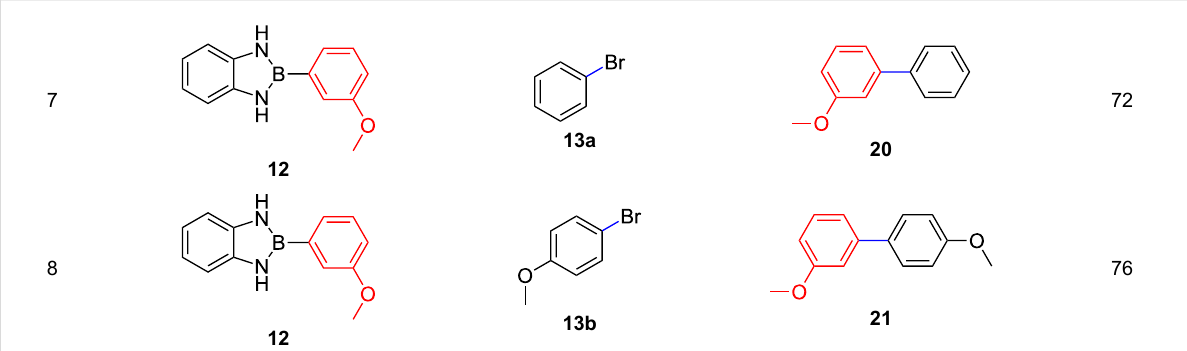
Table 2: Palladium-catalysed cross-coupling of boronate 9 – 12 with bromobenzene and 4-bromoanisole. a (continued)